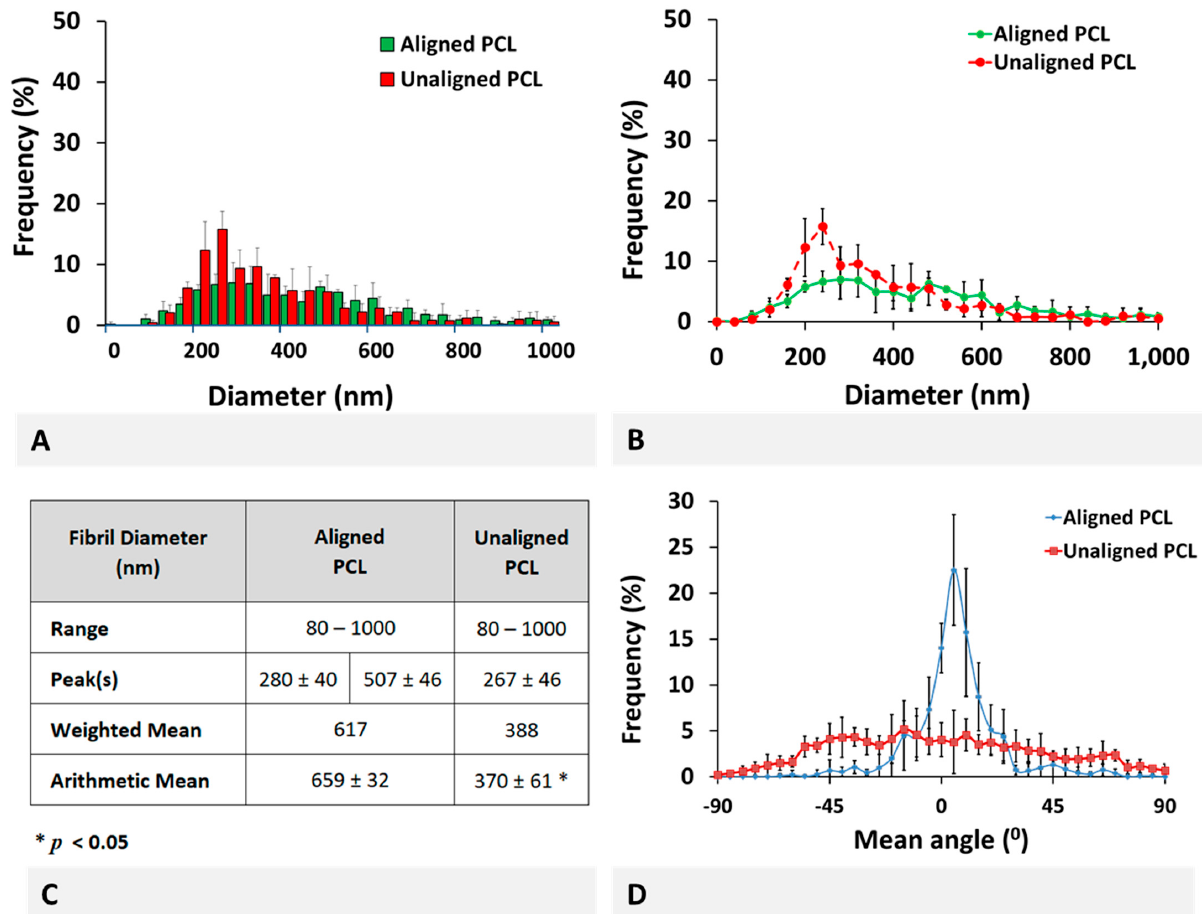
Figure 5. Combined aligned and unaligned polycaprolactone (PCL) fiber diameter distributions in ( A ) histogram, ( B ) line graph, and ( C ) descriptive statistics format, together with alignment measurements ( D ). * indicates statistically significant difference at p < 0.05 ( n = 3 for diameter measurements and n = 5 for alignment measurements) and error bars represent SD.